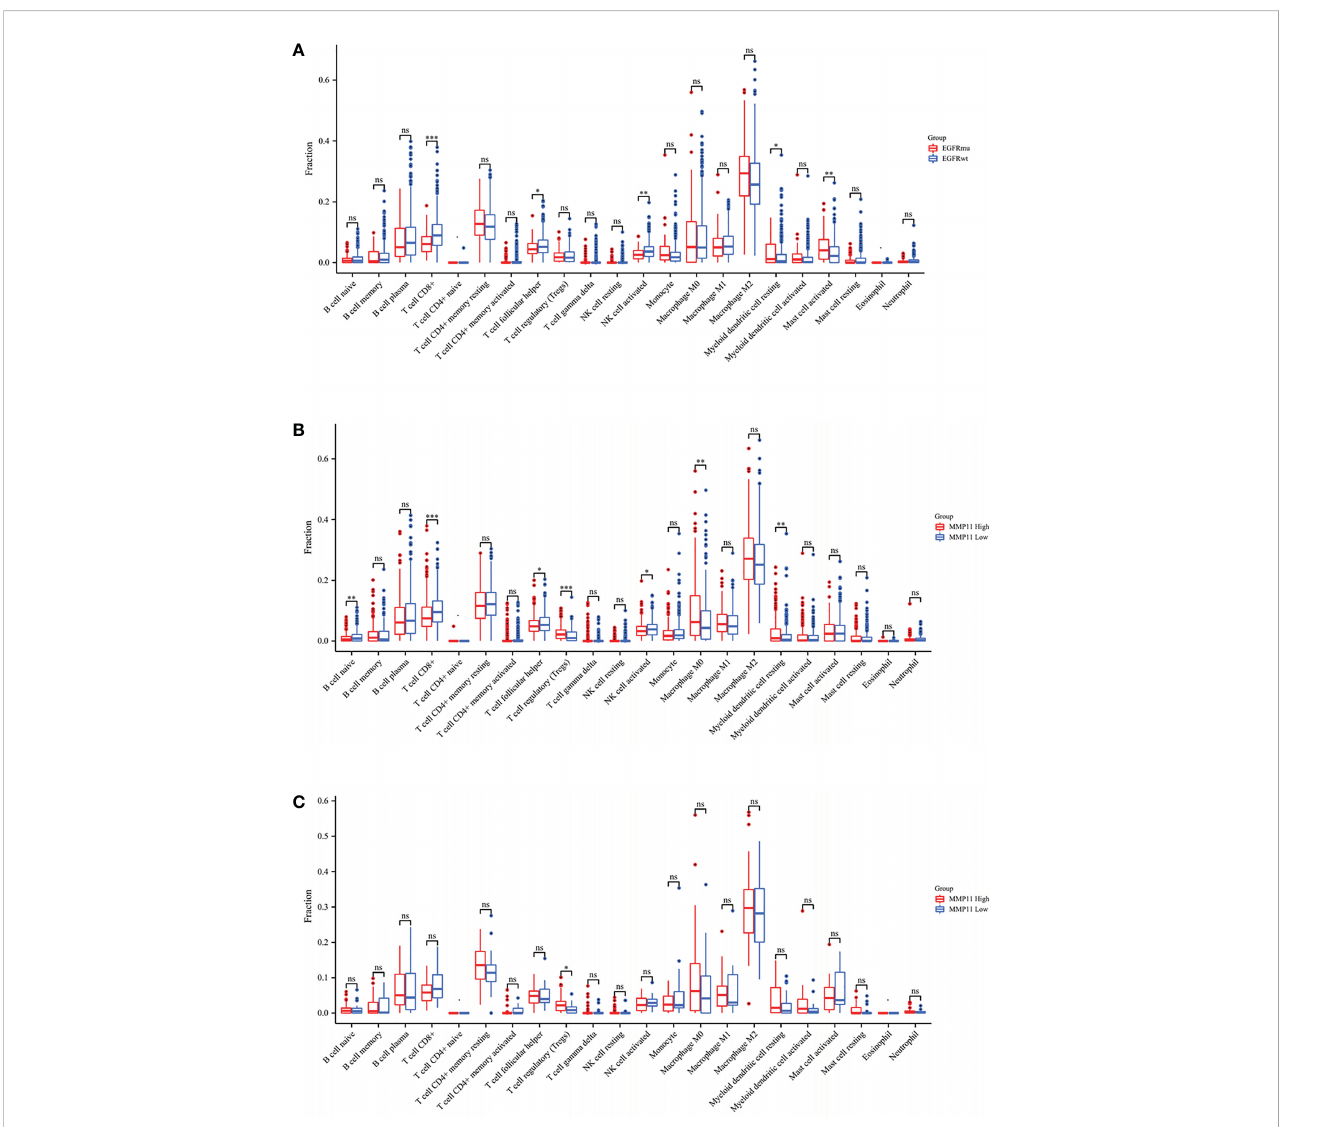
FIGURE 5 Differences in the in fi ltration of 22 immune cells in LUAD patients with TIME. (A) Results of high MMP11 expression group (red, n=258) compared to low expression group (blue, n=257) in TCGA-LUAD; (B) Results of EGFR mutation group (red, n=66) compared to a wild group (blue, n=445); (C) Results of high MMP11 expression group (red, n=46) compared to low expression group (blue, n=20) in EGFR-mutant LUAD; *P < 0.05; **P < 0.01; ***P < 0.001; ns, no statistical signi fi